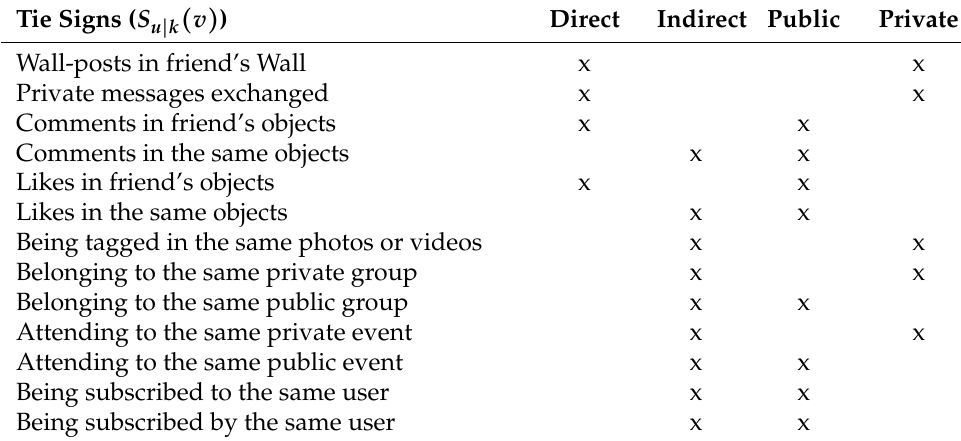
Table 1. Tie signs classification on Facebook